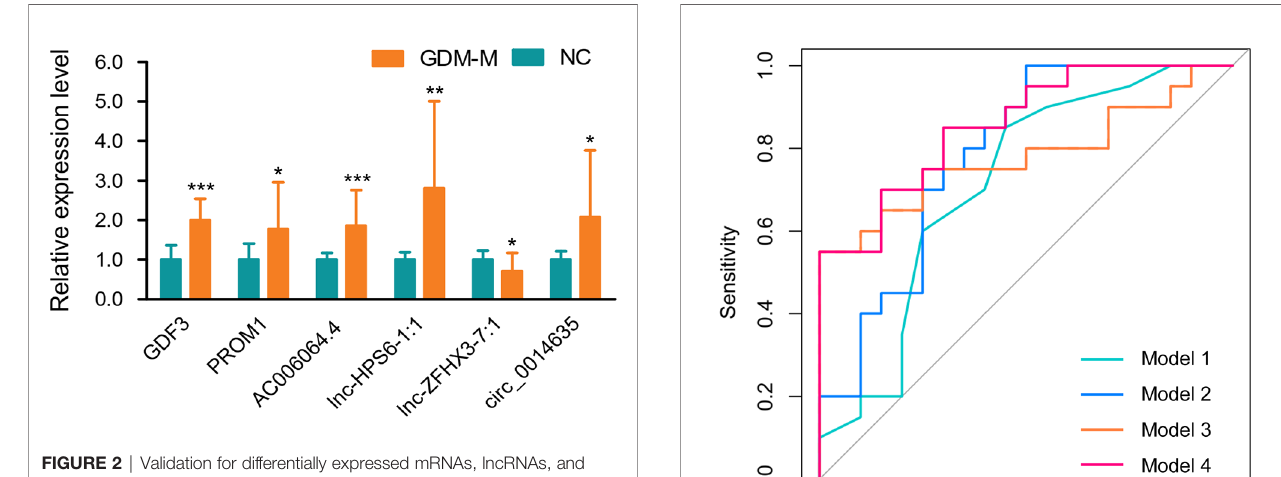
FIGURE 2 | Validation for differentially expressed mRNAs, lncRNAs, and circRNA by qPCR. * P < 0.01, ** P < 0.01, and *** P < 0.001. GDM-M, gestational diabetes mellitus and macrosomia; mRNA, messenger RNA; lncRNA, long non-coding RNA; circRNA, circular RNA.